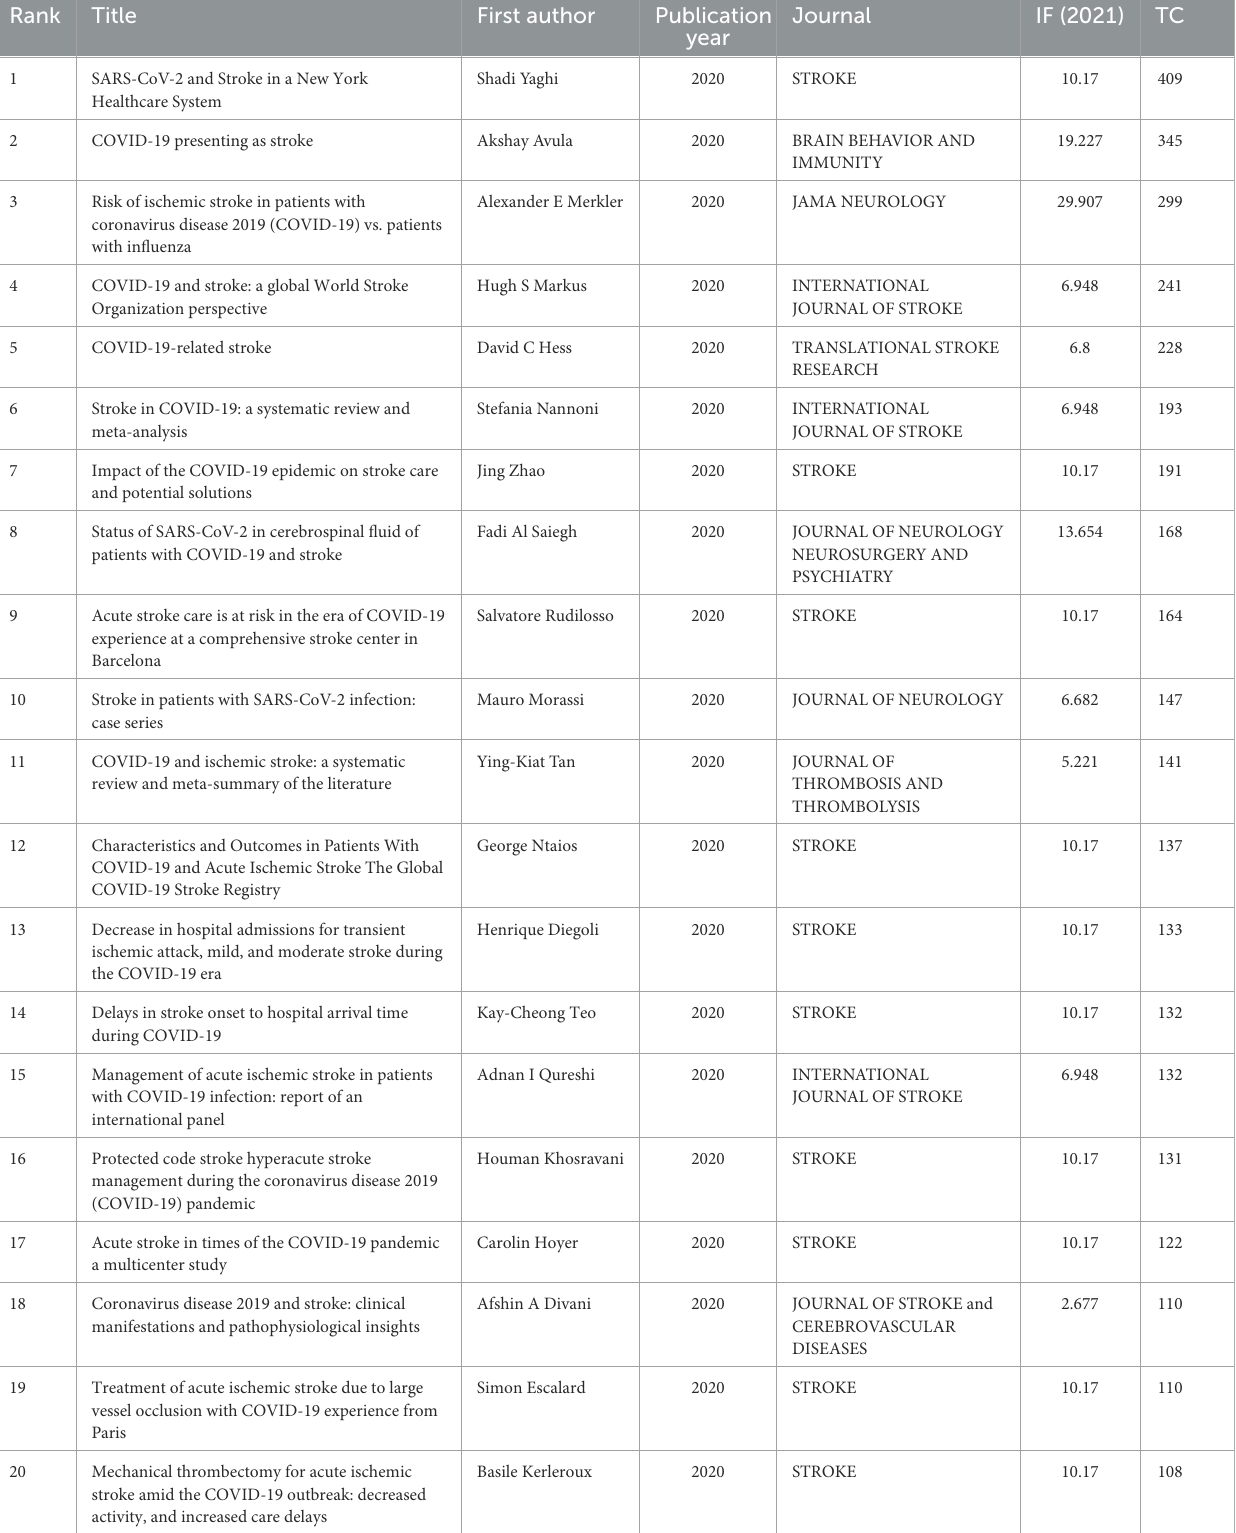
TABLE 5 Top 20 most-cited publications on COVID-19 and